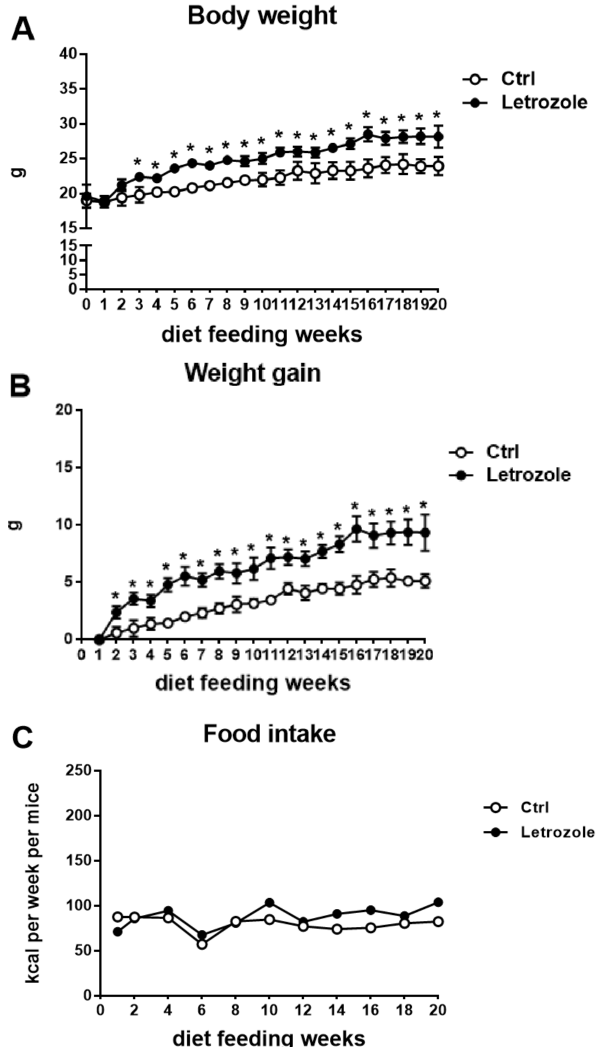
Figure 4. The body weight ( A ) and weight gain ( B ) of the letrozole-treated mice were significantly greater than in the control mice. The food intake showed no statistically significant difference between the two groups ( C ). Results are expressed as the mean ± SD. * p < 0.05, compared with the control mice.